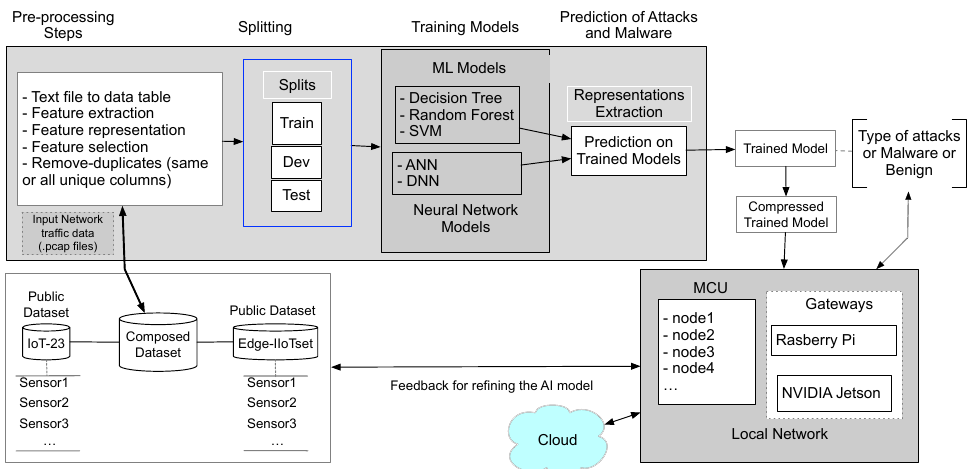
Figure 1. The framework workflow of the proposed method for IoT cybersecurity interconnecting different software and hardware